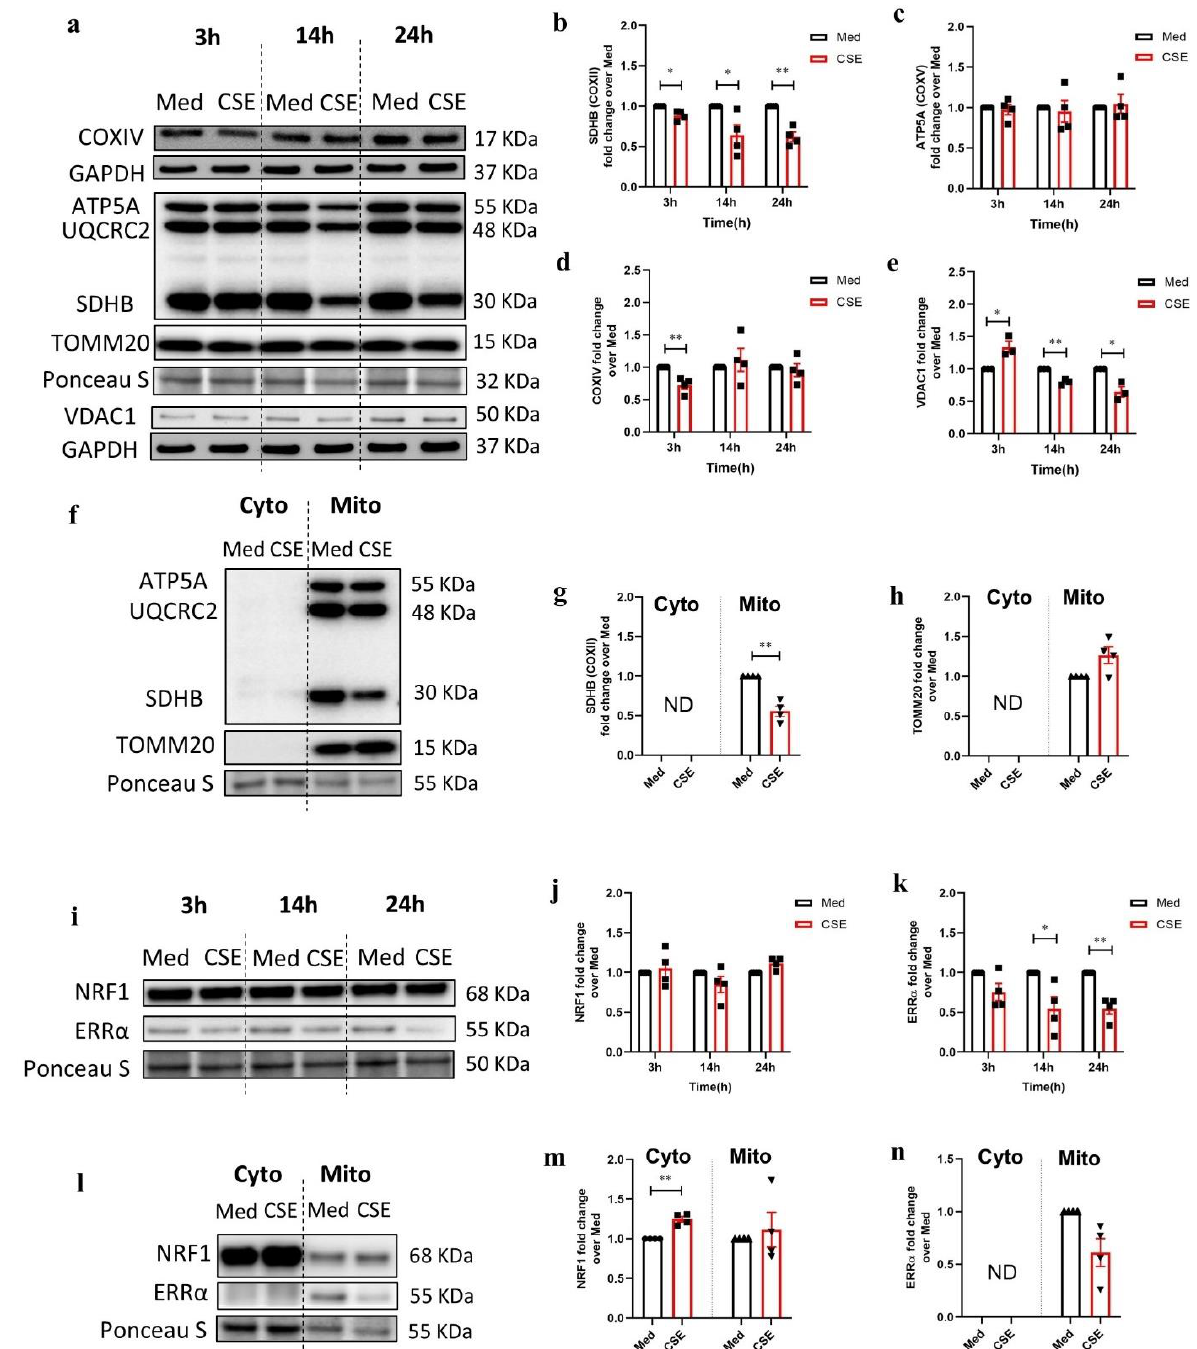
Figure 1. Abundance of mitochondrial complex (OXPHOS) components and constituents controlling mitochondrial biogenesis upon CSE stimulation in 16HBE cells. ( a ) Immunoblot representing protein expression of subunits of mitochondrial oxidative phosphorylation (OXPHOS) complexes: complex II (succinate dehydrogenase B-SDHB), complex III (cytochrome b-c1 complex subunit 2-UQCRC2), complex IV (cytochrome c oxidase subunit IV, COXIV), and complex V (ATP synthase subunit alpha- ATP5A); and translocase of the outer mitochondrial membrane complex subunit 20 (TOMM20) and voltage-dependent anion channel (VDAC1) in the total cell lysates of 16HBE cells incubated with medium (Med) as control or cigarette smoke extract (CSE) for 3 h, 14 h, and 24 h. Fold change of protein levels of ( b ) SDHB, ( c ) ATP5A, ( d ) COXIV, and ( e ) VDAC1 in the total cell lysates. The